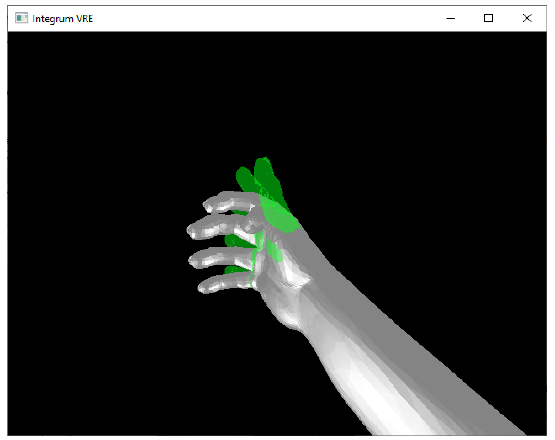
Figure 5. TAC test within the virtual hand environment provided by BioPatRec. The green hand indicates the reference hand; the gray hand represents the virtual prostheses. The participants could control the virtual prosthesis, and each hand motion was predicted in